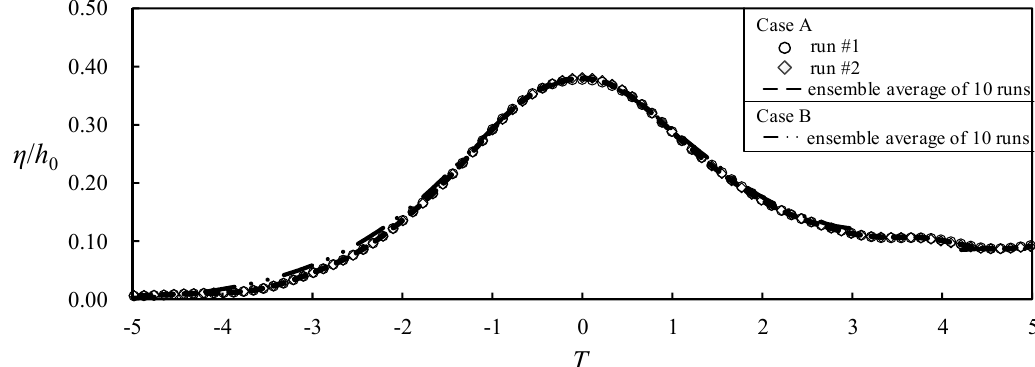
Figure 3. Comparison of the time series of the non-dimensional free surface elevation between Case A and Case B measured at x = 0 cm with respect to the non-dimensional time, T .